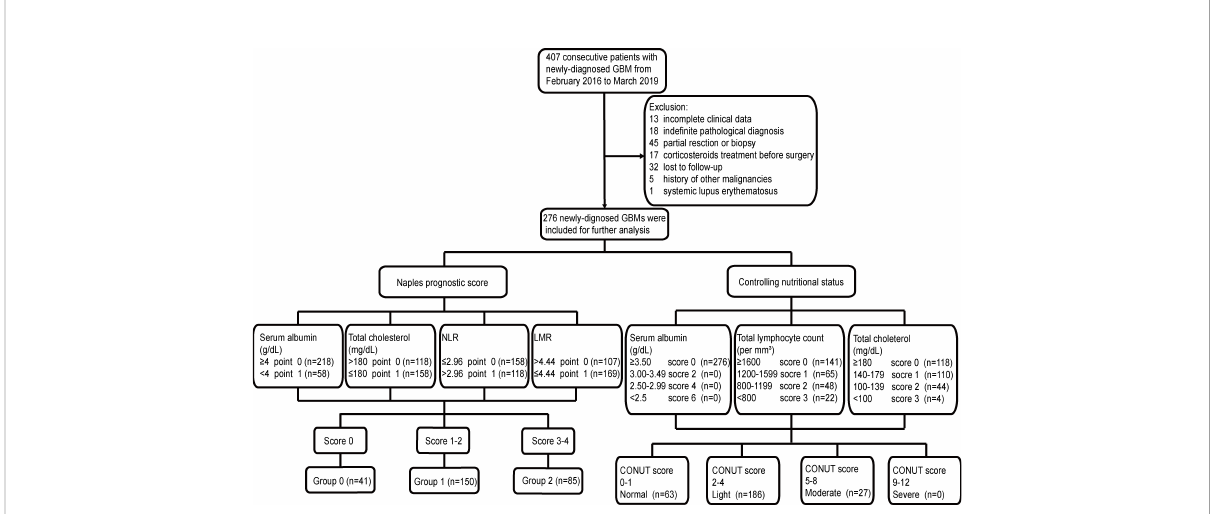
FIGURE 1 Flowchart of the current study. GBM, glioblastoma; NPS, Naples prognostic score; CONUT, Controlling Nutritional Status; NLR, neutrophil-to- lymphocyte ratio; LMR, lymphocyte-to-monocyte